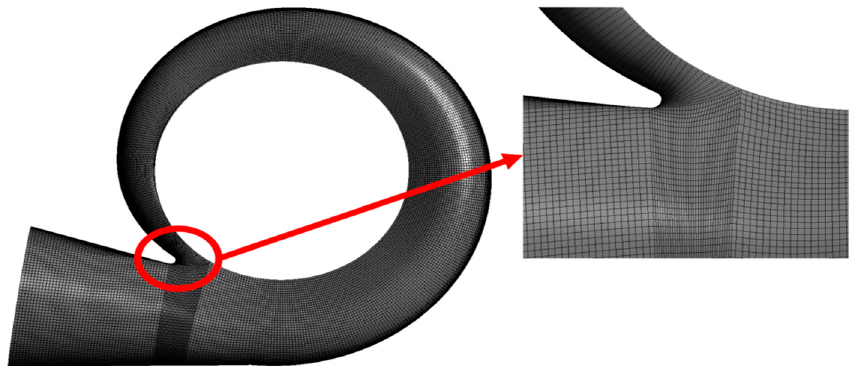
Figure 7. Grid distribution in the volute.